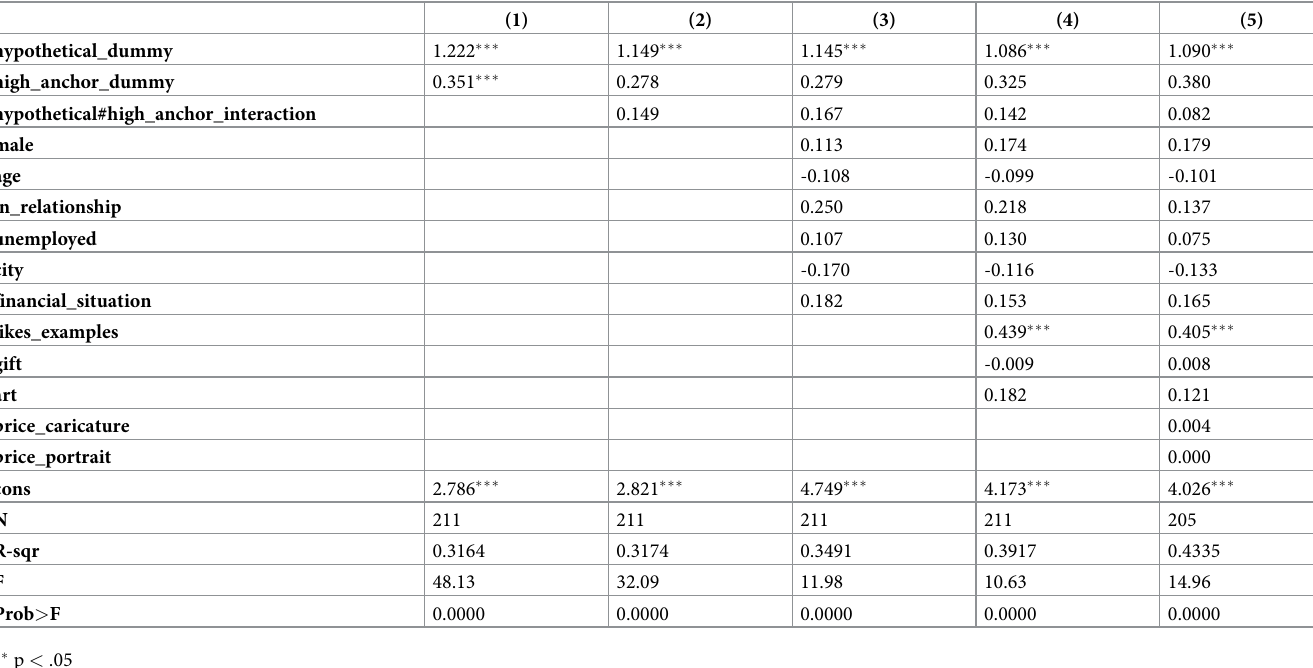
Table 4. Experiment 1: Regression table: WTP